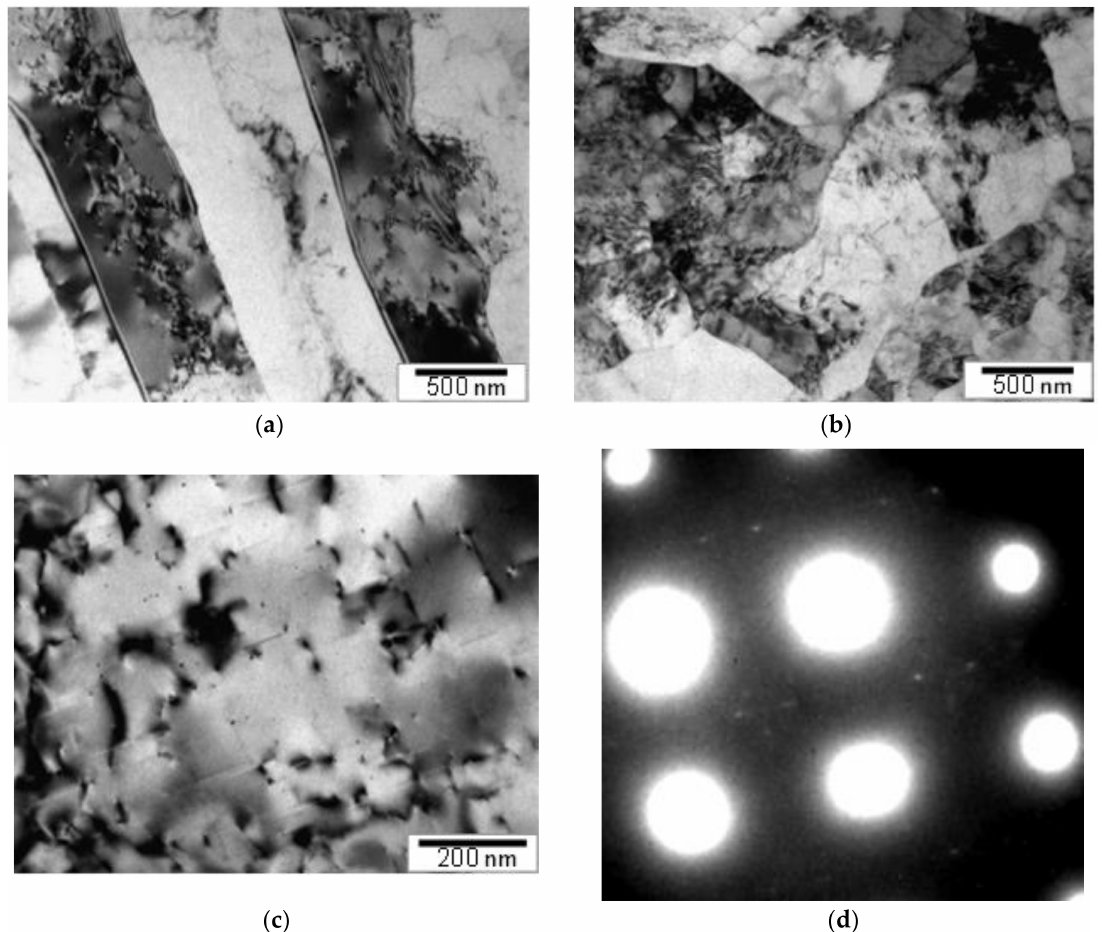
Figure 4. The Al 6101 alloy after conventional thermo-mechanical treatment T81: ( a ) microstructure on longitudinal section; ( b ) microstructure on transversal section; ( c ) bright field TEM image showing strengthening second-phase precipitates present in the Al matrix; and ( d ) corresponding SAED patterns (the crystal is close to the [001] zone axis orientation),